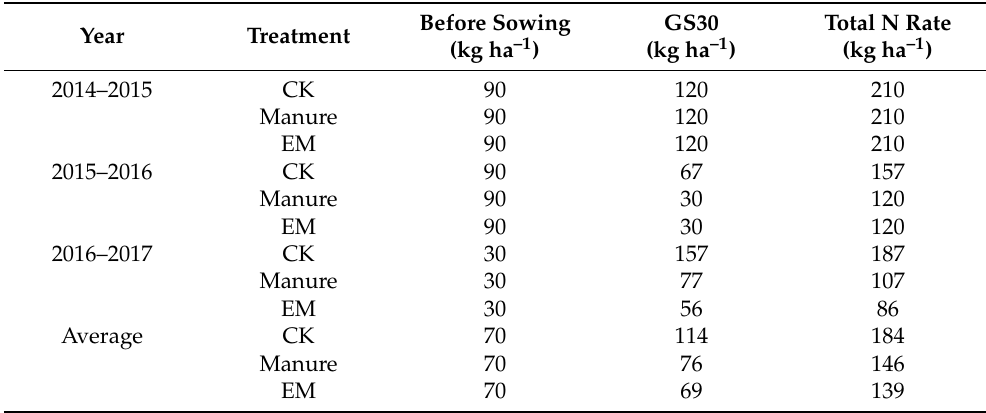
Table 2. Rates and times of nitrogen (N) application during the experiment based on an in-season nitrogen management (INM)